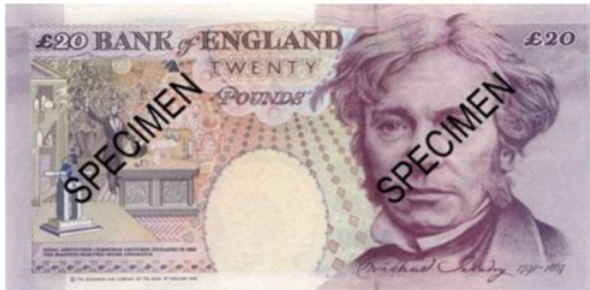
Figure 21. A 20-pound banknote with the Faraday effigy